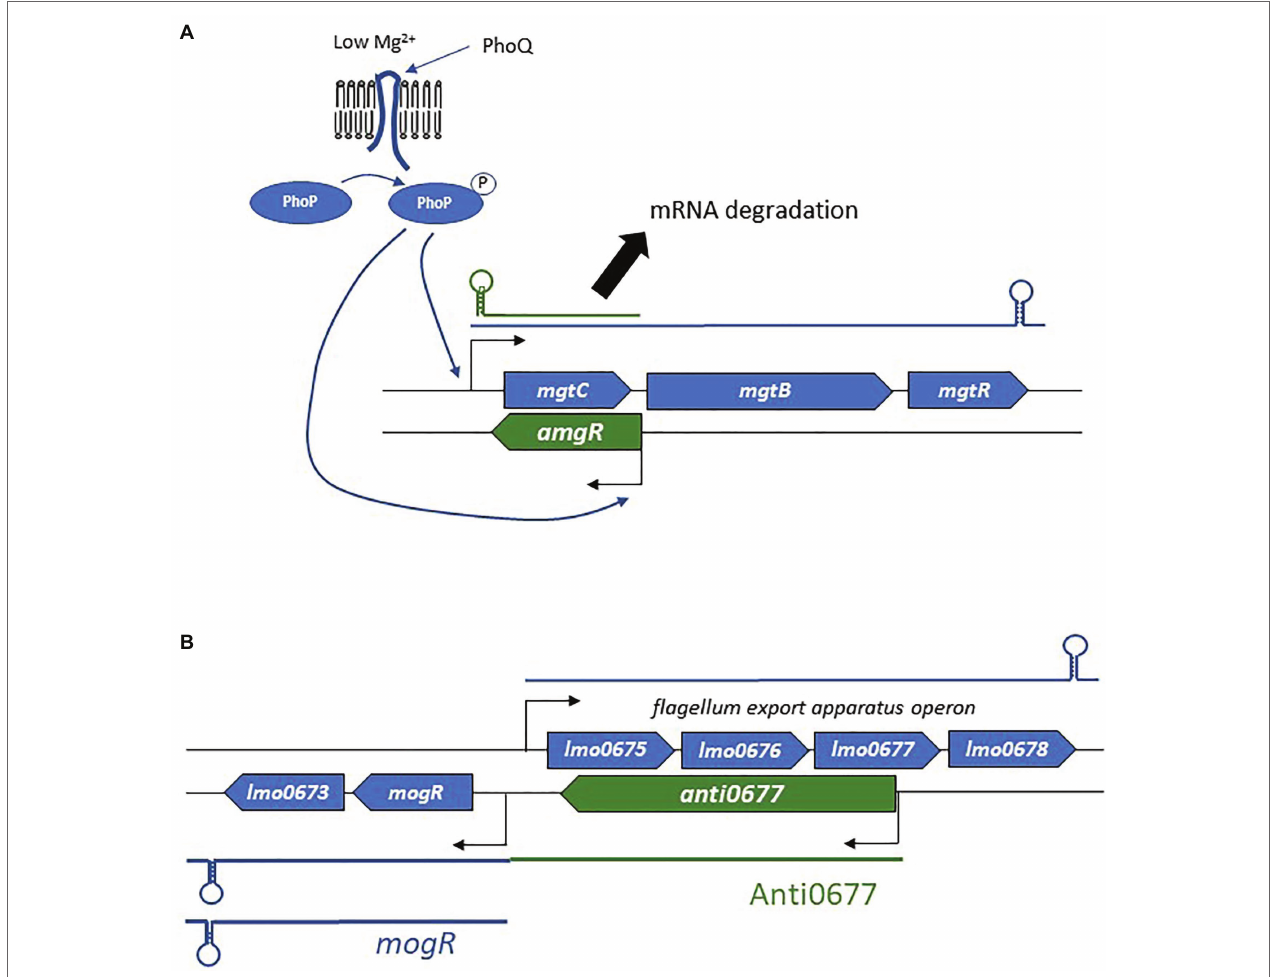
FIGURE 4 | Examples of the mechanism of actions employed by asRNAs. (A) Regulation of the mgtCBR operon and the role of AmgR in degradation of mgtC mRNA. (B) Schematic representation of the flagellum biosynthesis excludon downregulated by the long asRNA